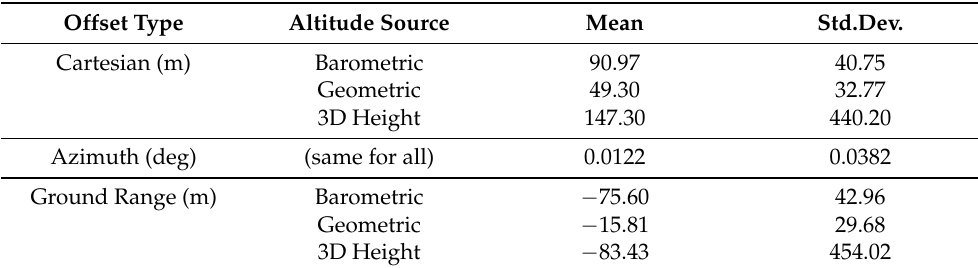
Table 3. Gaussian Parameters of Full Series in Figure